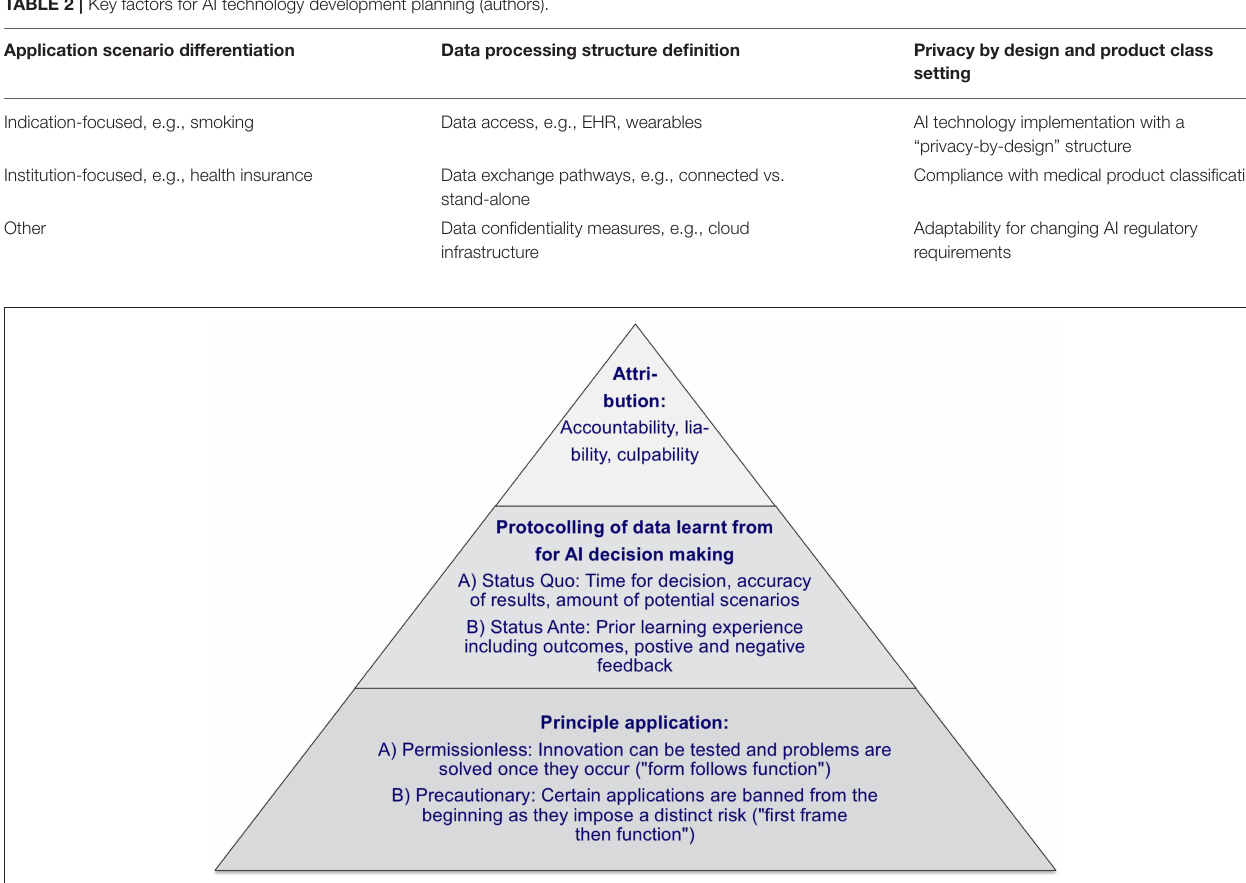
TABLE 2 | Key factors for AI technology development planning (authors).